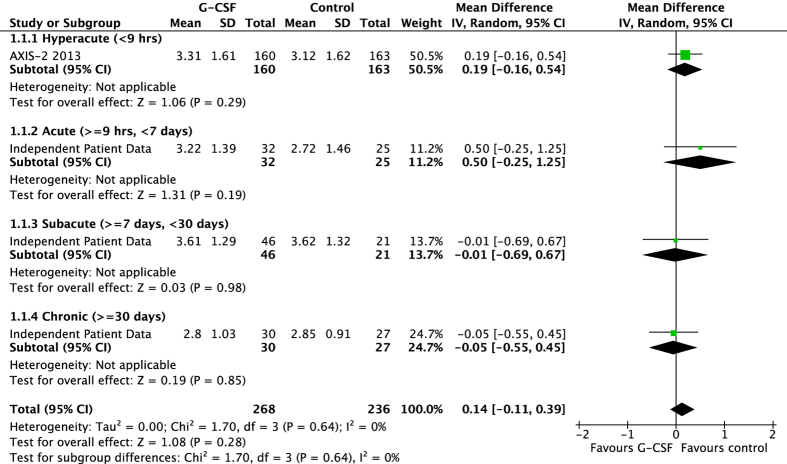
The effect of time of administration on end-of-trial modified Rankin scale according to treatment group; subgroups are divided into hyperacute (<9 hours), acute (9 hours to <7 days) subacute (7 to 30 days) and chronic (>30 days) phases of stroke.